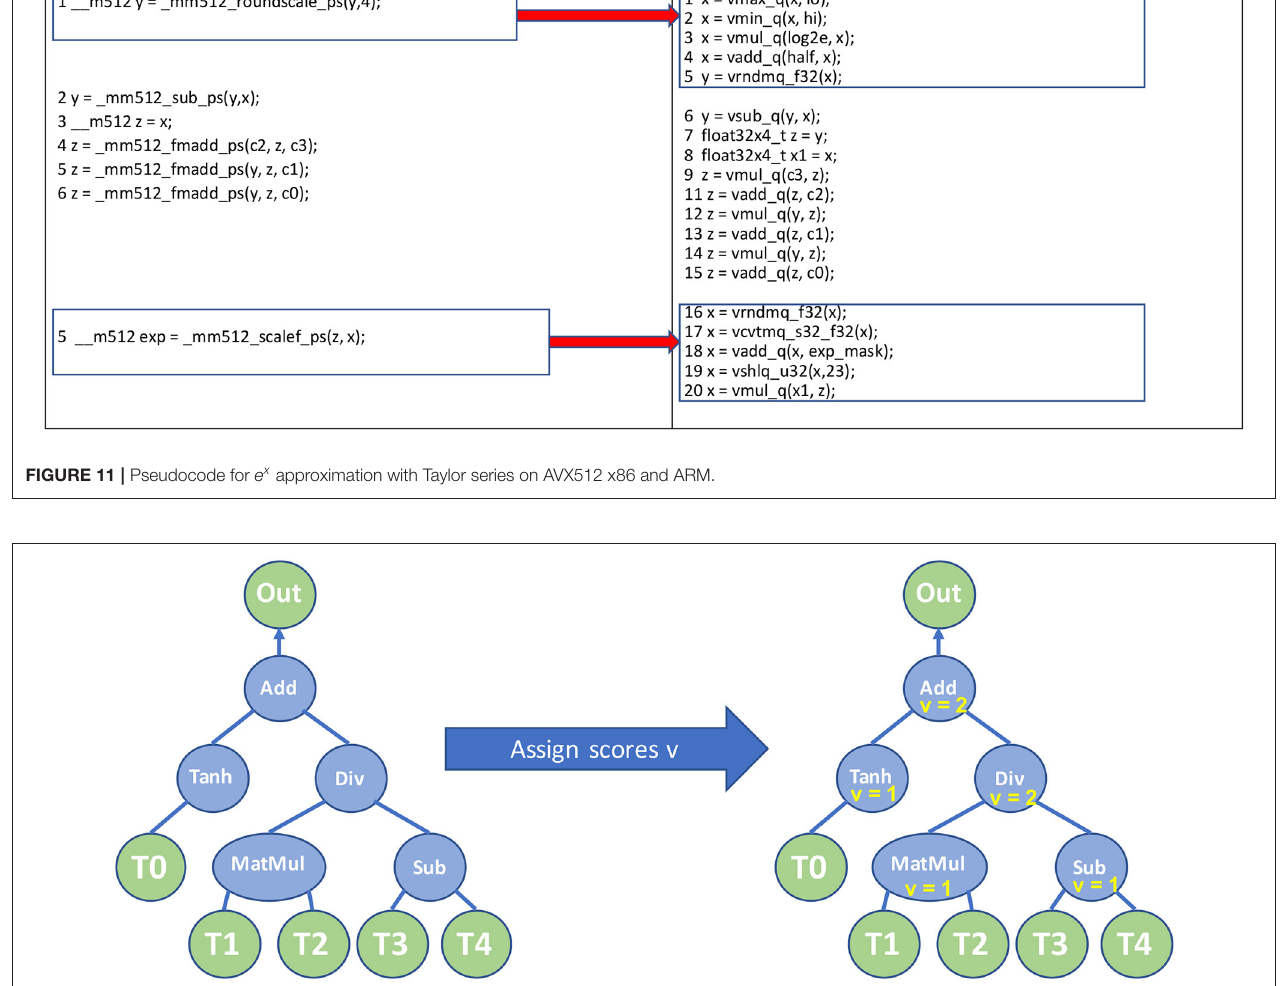
FIGURE 12 | Left: TPP Equation tree for Out = Tanh ( T 0 ) + ( T 1 × T 2 ) / ( T 3 − T 4 ). Right: Assigned register scores v on the equation TPP nodes after running Algorithm 3